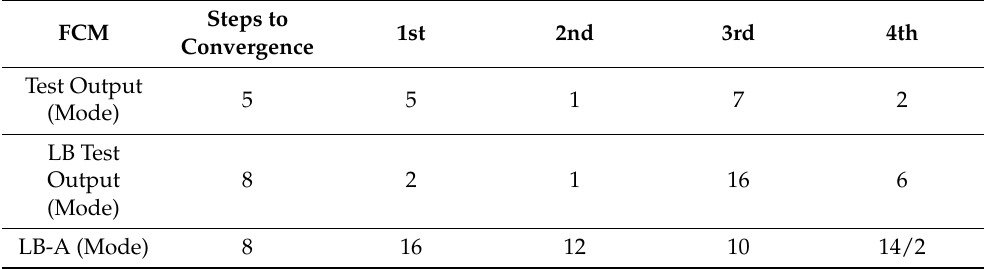
Table 10. Mode of FCM convergence output values 1